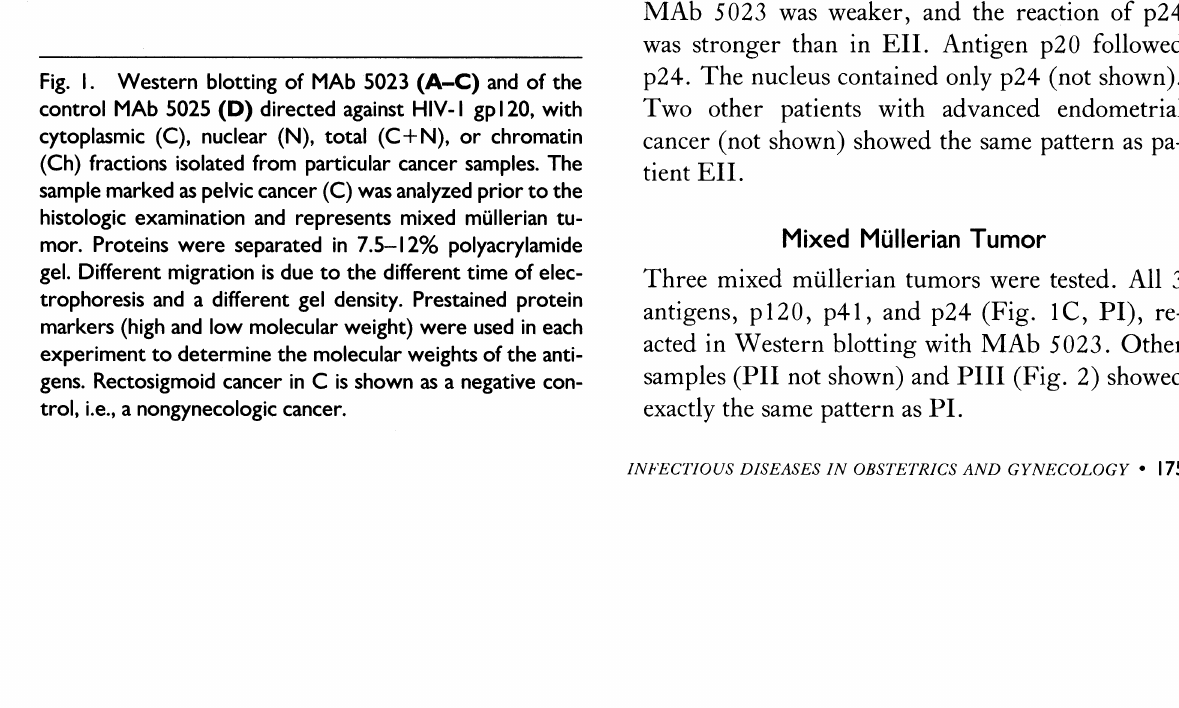
Fig. I. Western blotting of MAb 5023 (A-C) and of the control MAb 5025 (D) directed against HIV-I gpl20, with cytoplasmic (C), nuclear (N), total (C+N), or chromatin (Ch) fractions isolated from particular cancer samples. The sample marked as pelvic cancer (C) was analyzed prior to the histologic examination and represents mixed millerian tu- mor. Proteins were separated in 7.5-12% polyacrylamide gel. Different migration is due to the different time of elec- trophoresis and a different gel density. Prestained protein markers (high and low molecular weight) were used in each experiment to determine the molecular weights of the anti- gens. Rectosigmoid cancer in C is shown as a negative con- trol, i.e., a nongynecologic cancer.